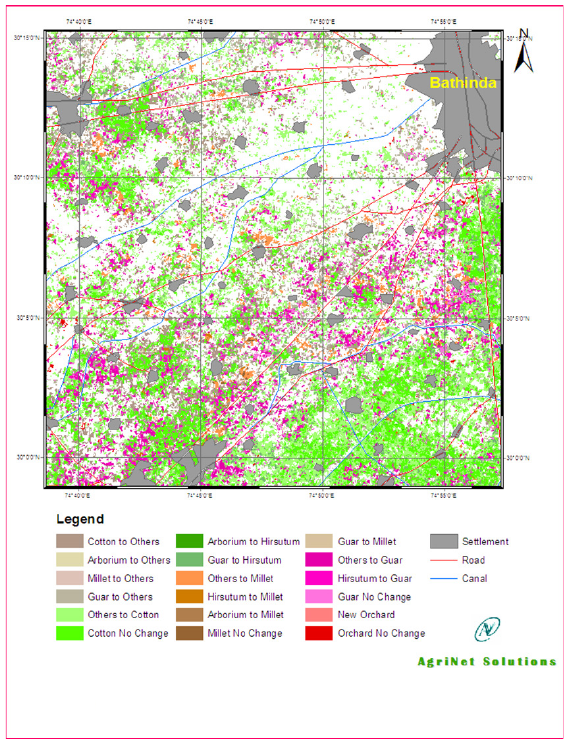
various host crops in different blocks are as follows: